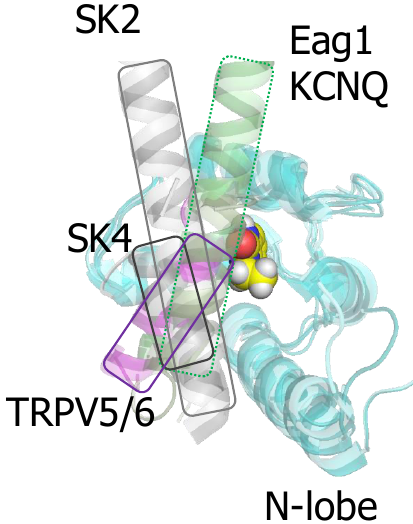
Figure 7. The N-lobe drug binding site of SK channels. Superposition of the N-lobe engaged with the target helix of TRPV5/6 (purple), SK4 (dark grey), SK2 (grey), Eag1 and KCNQ (green) on the complex of SK2 with EBIO (PDB 4G28). The position of the helices from Eag1 and KCNQ do not appear to be compatible with the presence of this drug.